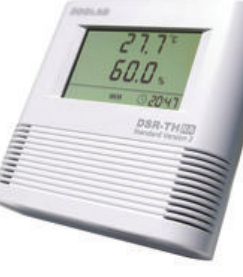
Figure 5: Hygrothermograph. Table 2: Hygrothermograph technical specifications.